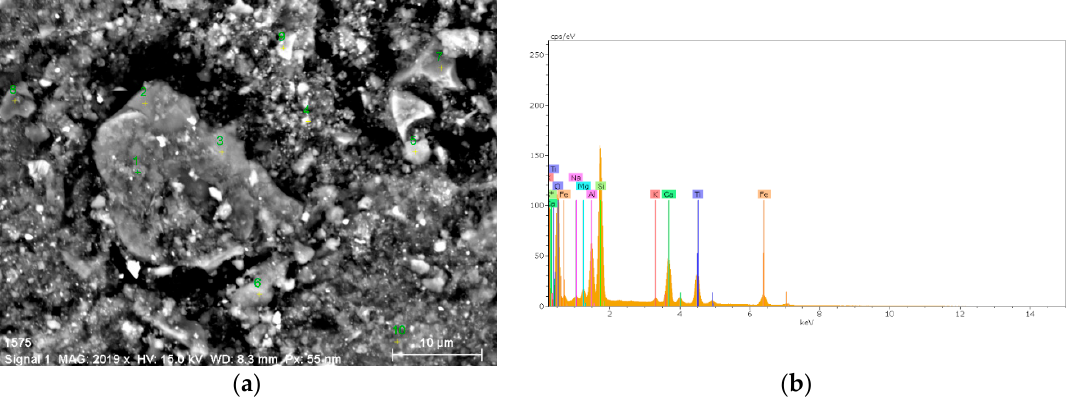
Figure 10. ( a ) SEM image with indicated region of the X-ray analysis, ( b ) X-ray analysis of the indicated region.